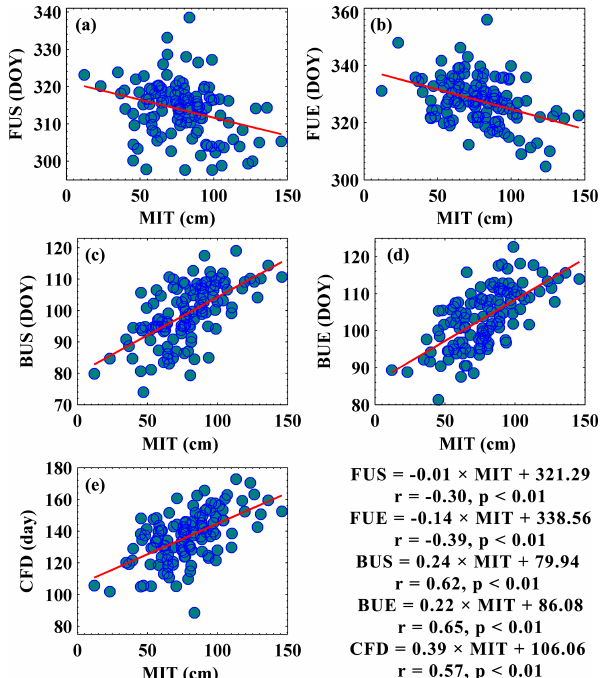
Figure 8. The bivariate scatter plots with linear regression lines be- tween yearly maximum ice thickness (MIT) and ice phenology with a dataset size of 120; r and p denote the correlation coefficient and p value of the regression line. The ice phenology events include freeze-up start (FUS), freeze-up end (FUE), break-up start (BUS), break-up end (BUE), and complete frozen duration